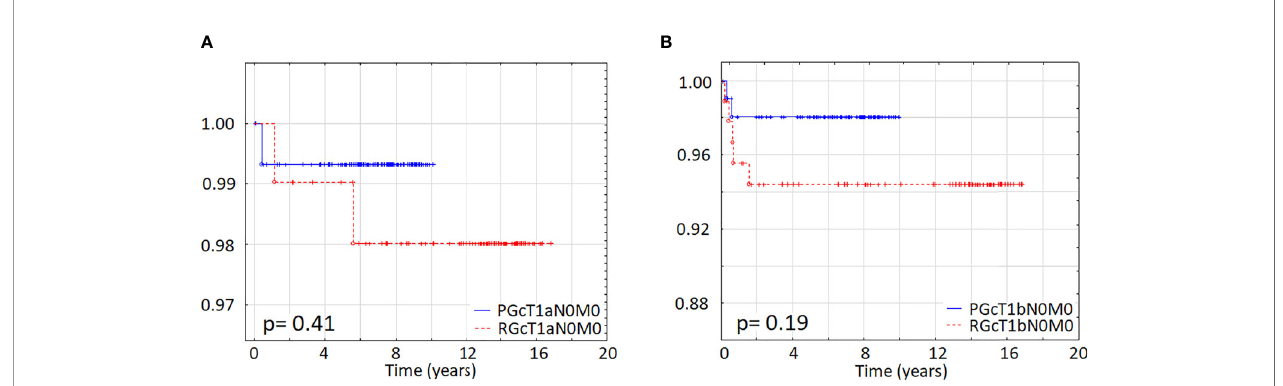
FIGURE 2 | Disease-free survival was not different between the groups (A) Comparison between the prospective group (PGcT1aN0M0) and the retrospective population (RGcT1aN0M0) (B) Comparison between the prospective group (PGcT1bN0M0) and the retrospective group